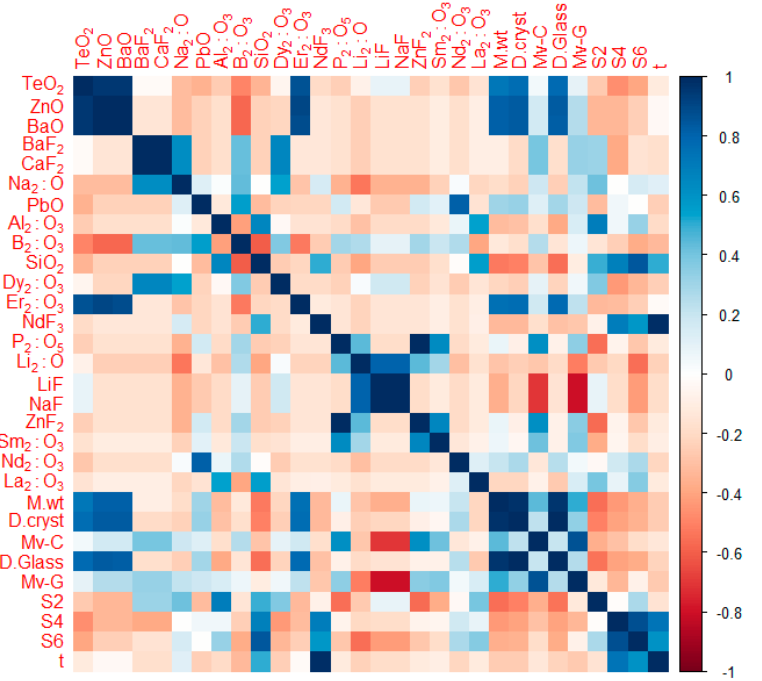
Figure 3. The correlation matrix between the outcomes and input features. Percentage relative error ( PRE ): The proportion of percentage error between the esti- mated outputs and the real observed value, which is calculated as follows: